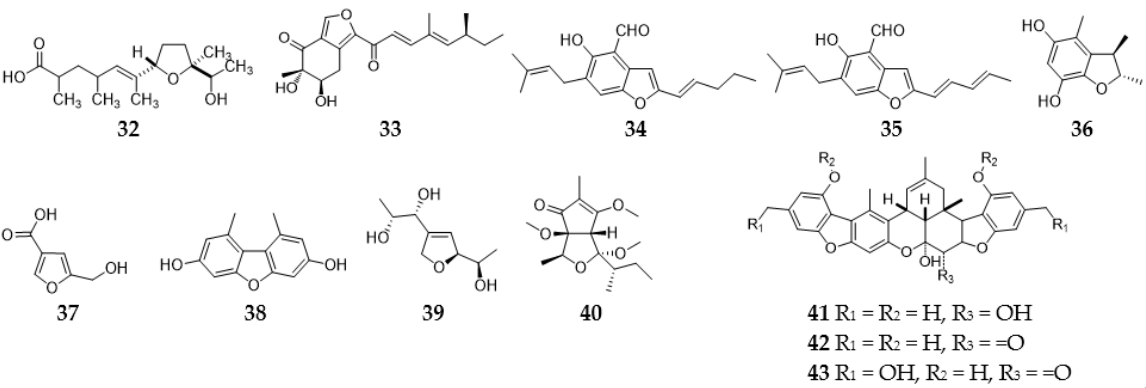
Figure 3. Aspergillus -derived furans and benzofurans ( 32 – 43 ).